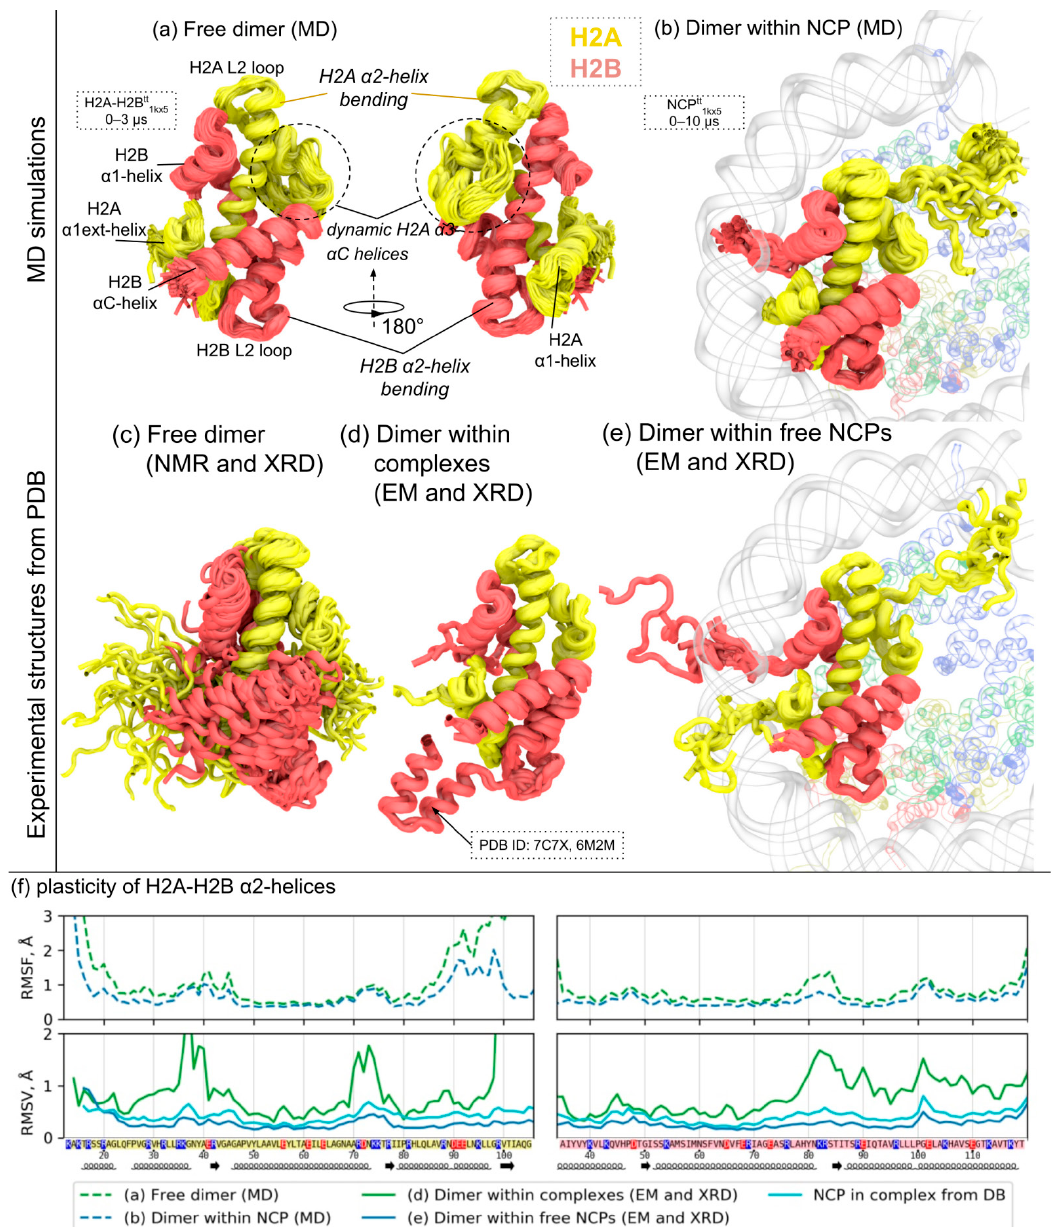
Figure 2. H2A-H2B dimer dynamics in molecular dynamics (MD) simulations and experimental